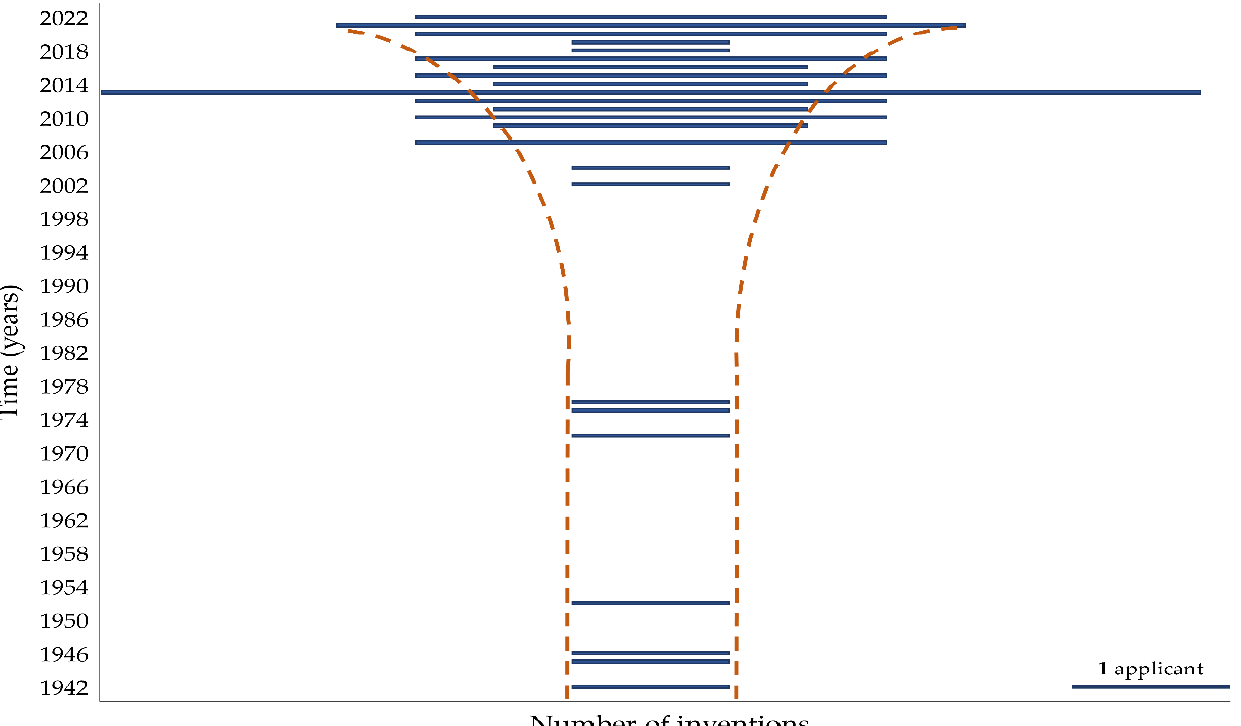
Figure 2. The funnel plot. Approximate growth of patent applications in time.